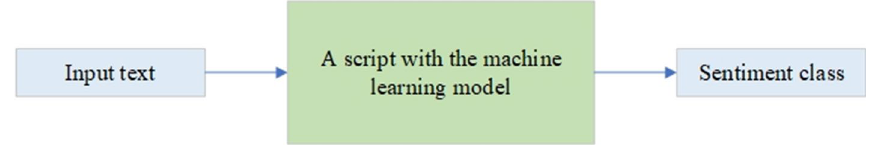
Fig. 22 New text